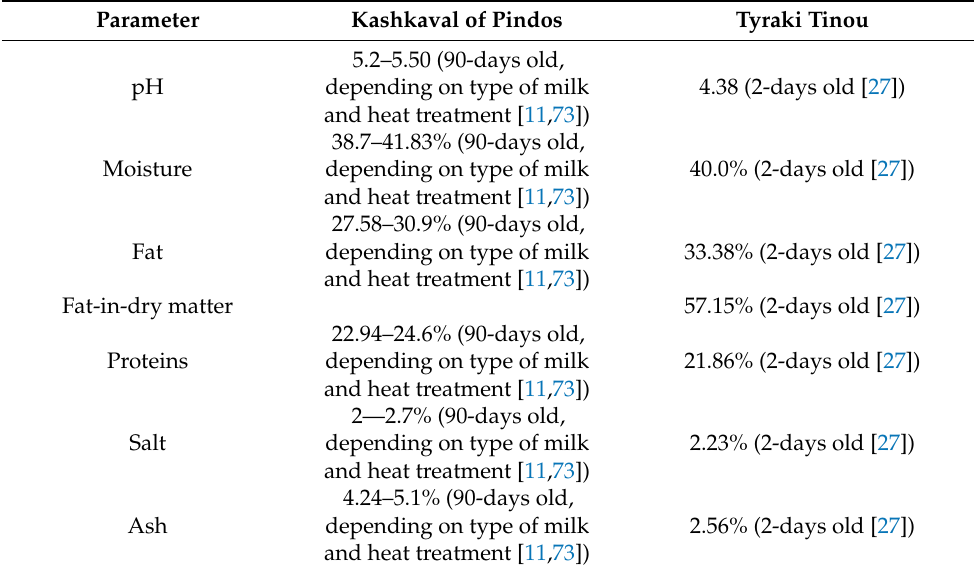
Table 6. Composition of nonprotected designation of origin and nonprotected geographical indication semihard